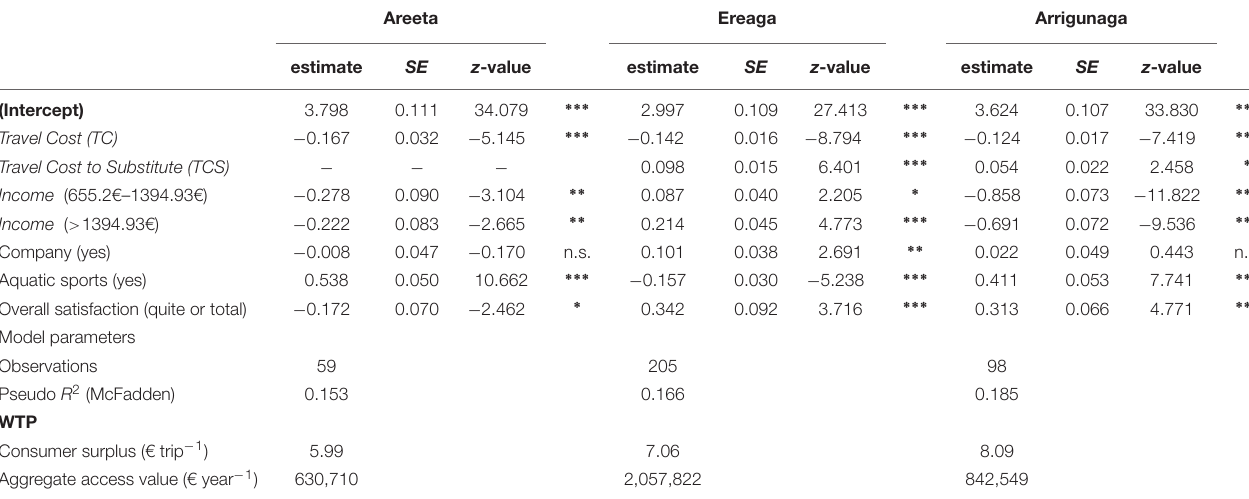
TABLE 4 | Poisson models for recreational trips to Areeta, Ereaga, and Arrigunaga and the single and aggregate surplus. Areeta Ereaga Arrigunaga